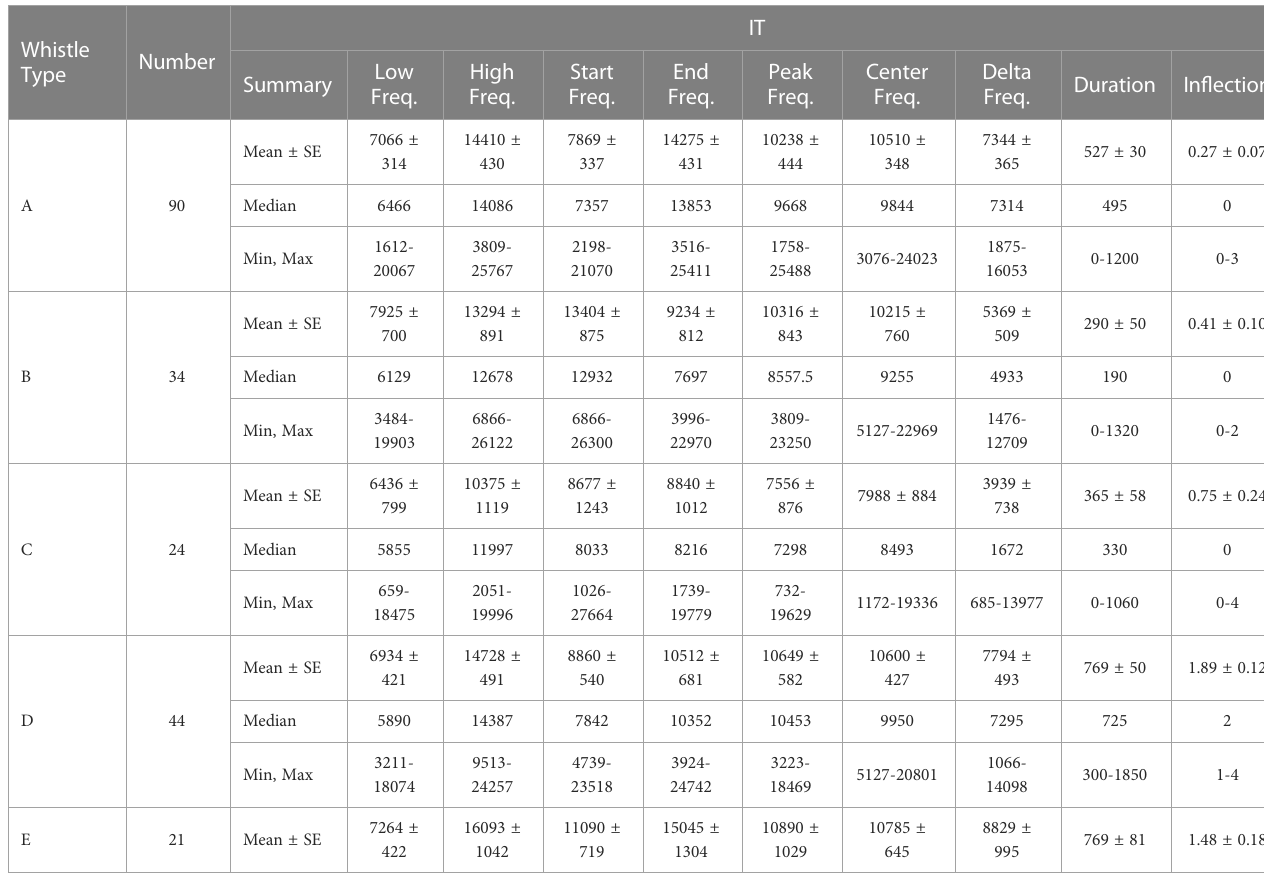
TABLE 5 Summary statistics of detected whistle types in the Taranto Gulf and in the Boka Bay.